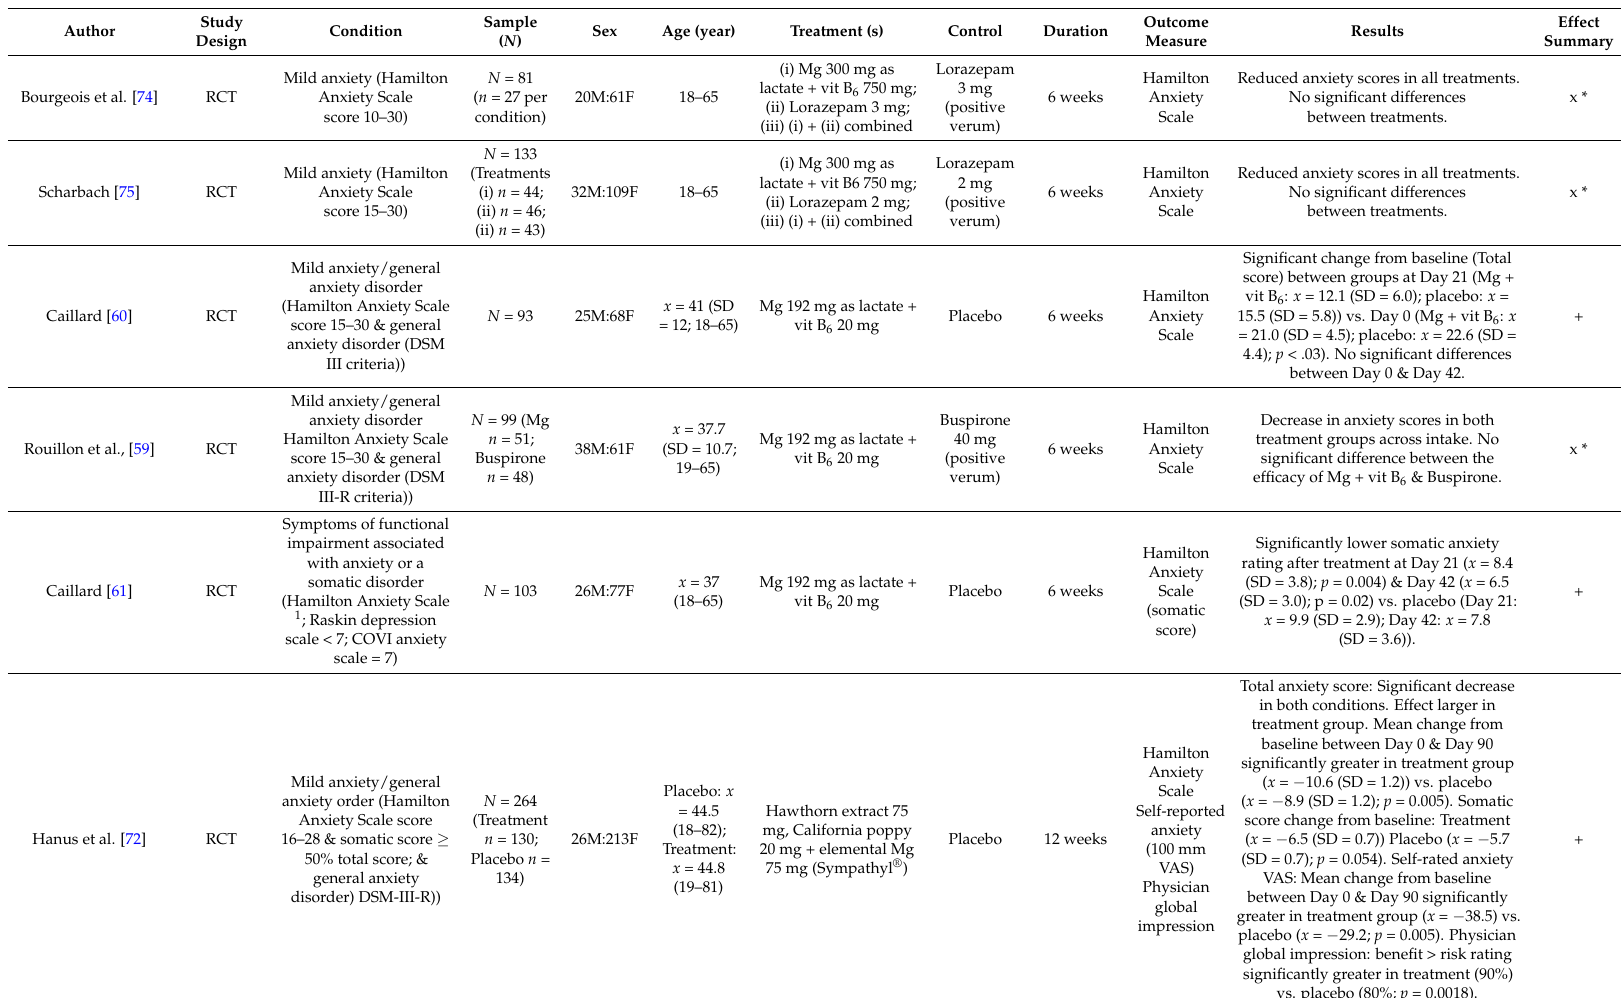
Table 1. Summary of studies reporting the effects of Mg on subjective anxiety/stress in mild to moderately anxious